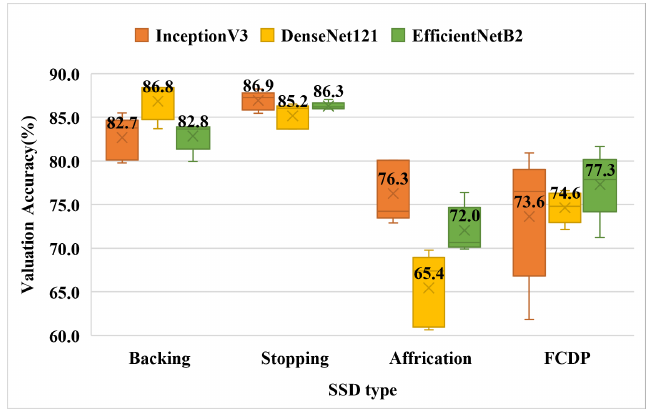
Figure 8. Validation accuracy of single Chinese character binary classification box plot (Experiment-2).